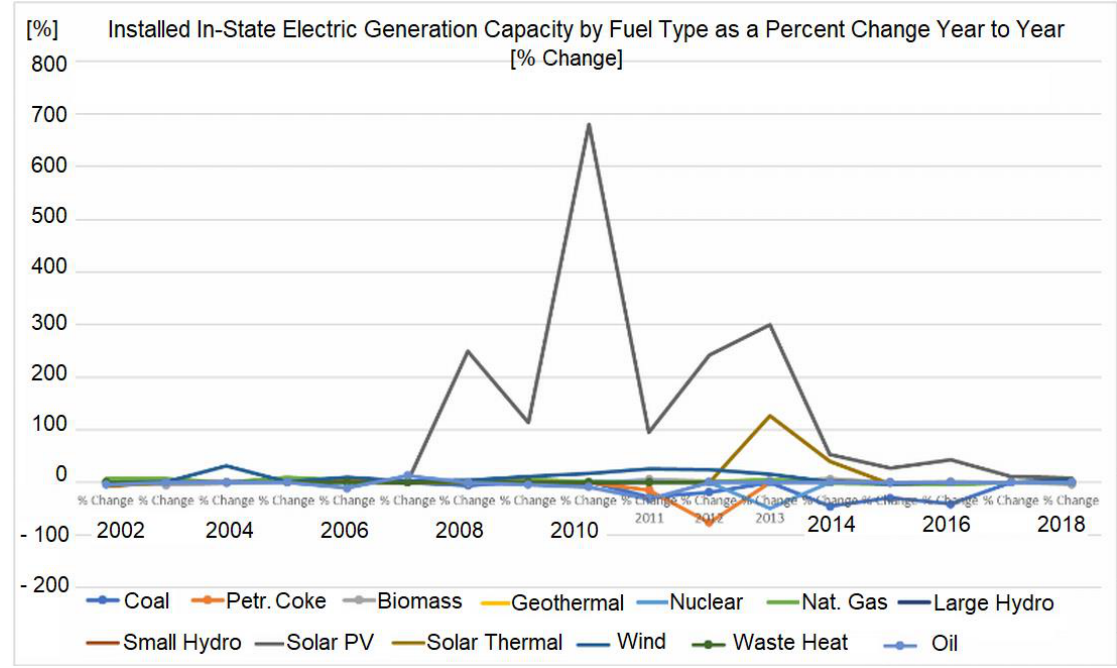
Figure 3. California’s capacity by yearly percentage chang e.